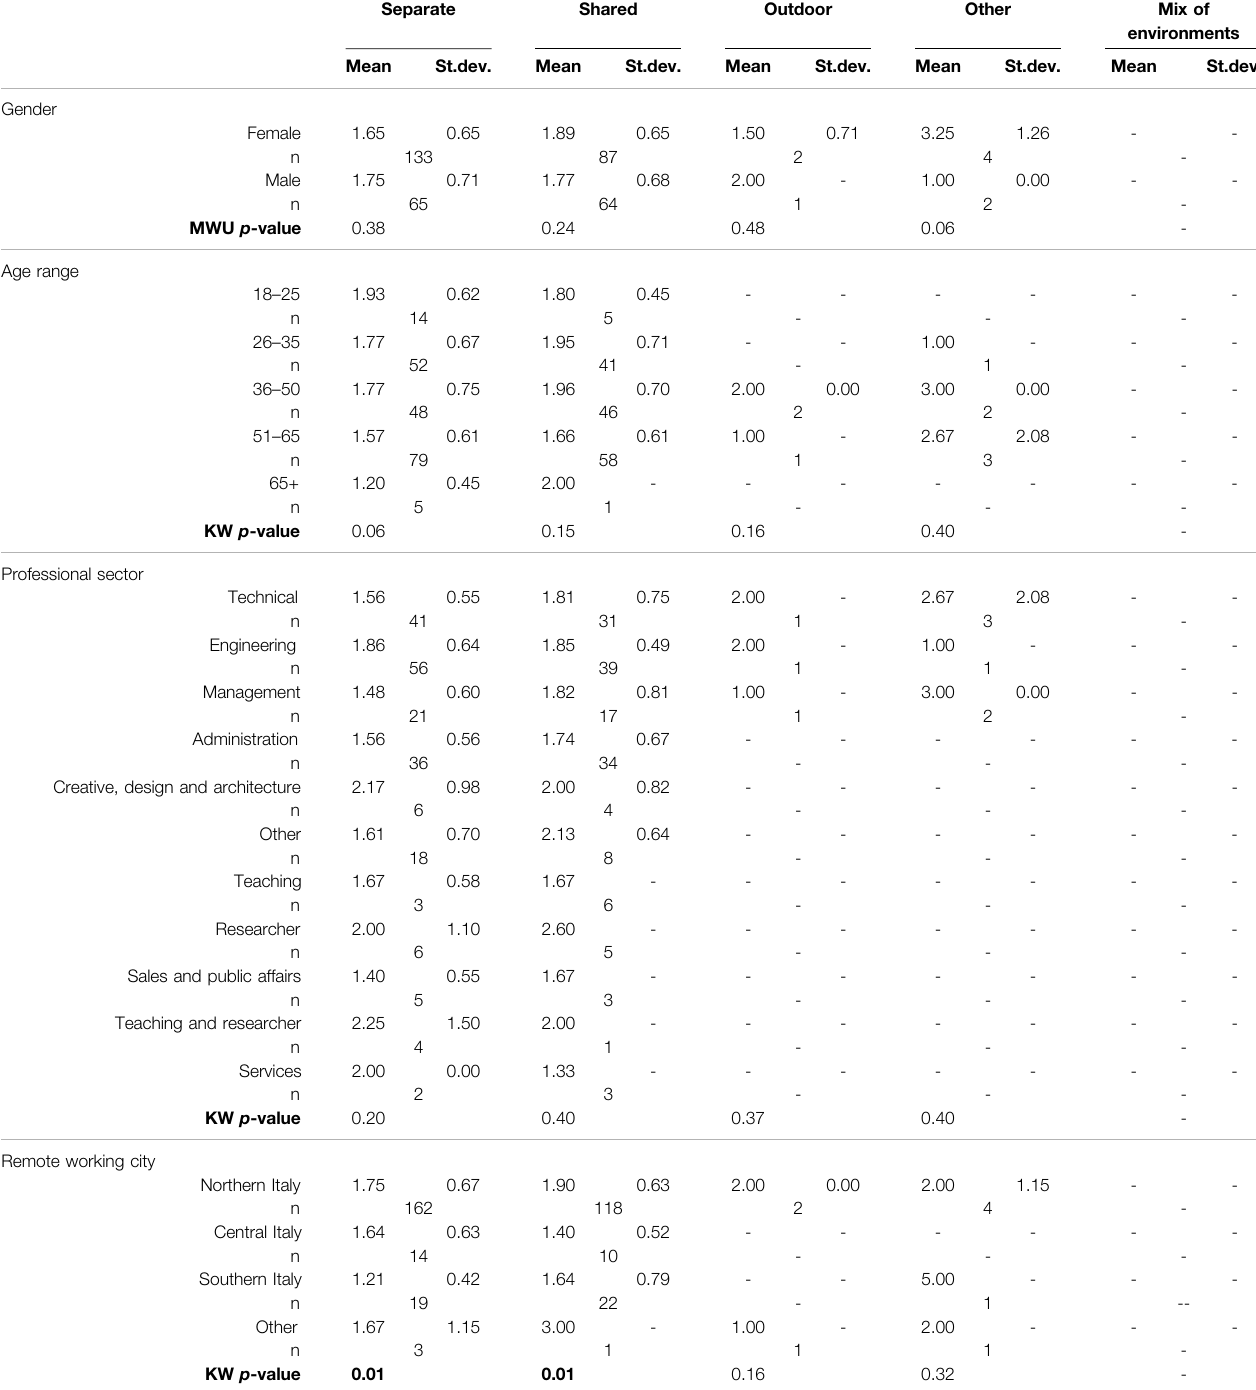
TABLE7| Meanandstandarddeviation(St.dev.)valuesoftheanswersgivenbynonsensitivetonoiserespondents( n (cid:1) 358)onnoiseannoyance(Q1)relatedtogender,age range, professional sector, and remote working city for different types of environment. Two-tailed p -values of signi fi cance of the differences according to the Mann Whitney U (MWU) or Kruskal Wallis (KW) Test are reported. Statistically signi fi cant differences with p -values < 0.05 are reported in